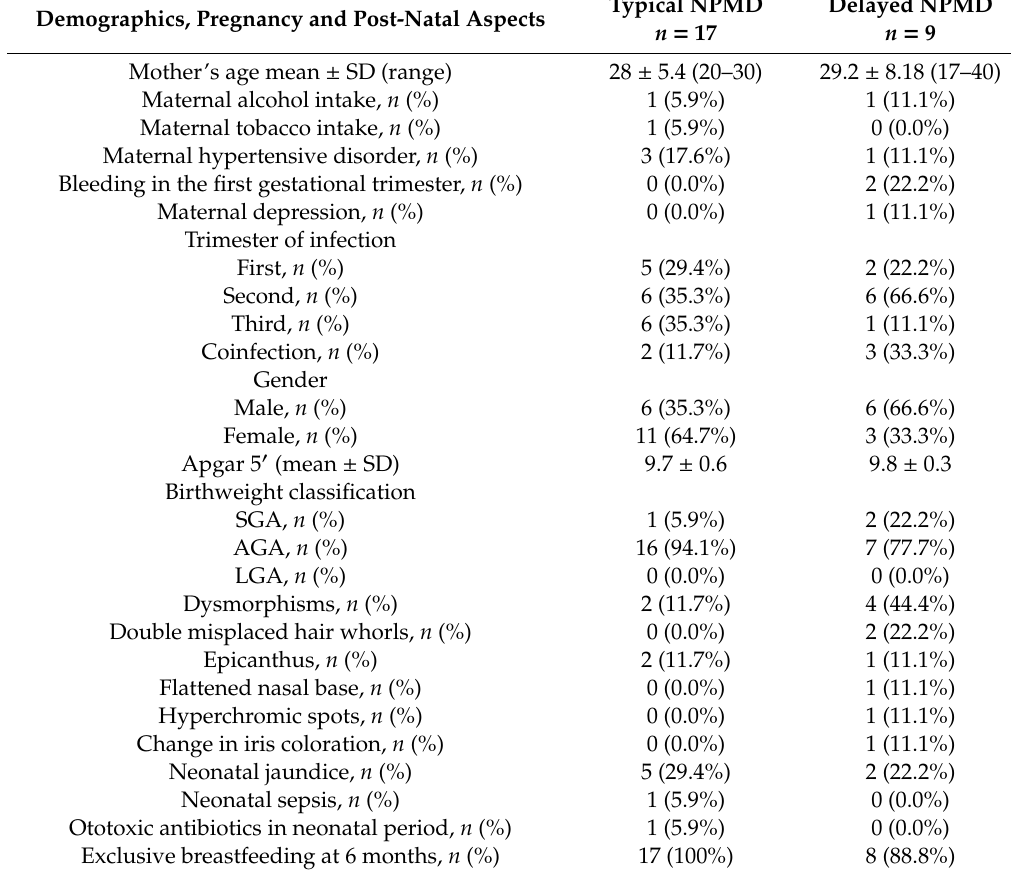
Table 1. Demographics, pregnancy, post-natal aspects, and Bayley Scales of Infant and Toddler Development—Third Edition (BSID-III) results of 26 non-microcephalic children exposed to the Zika virus in the intrauterine period, Manaus, Amazonas,